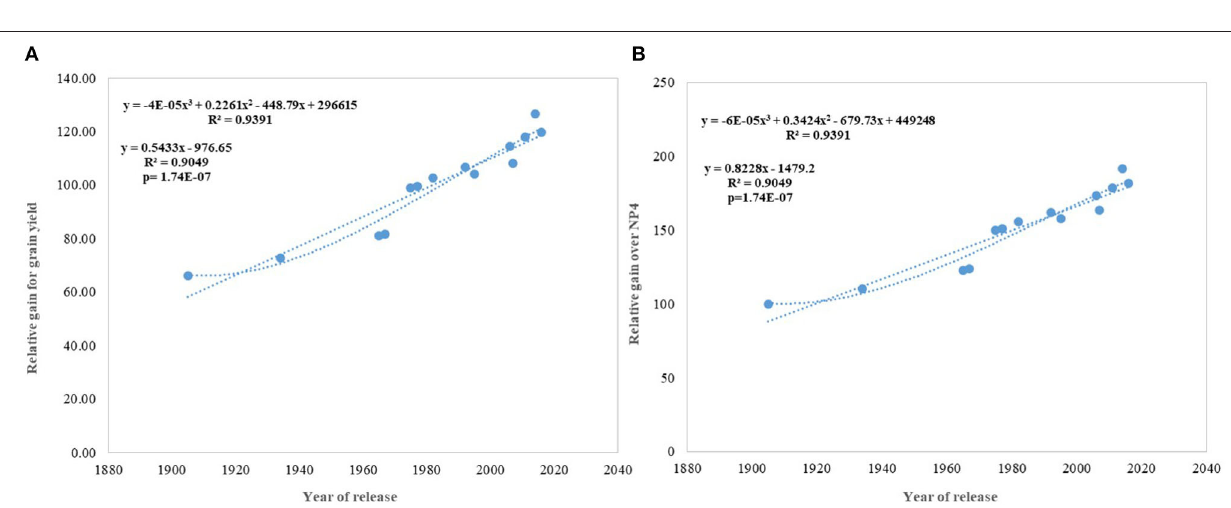
FIGURE 5 | Relative genetic gain over the average of all varieties and NP4 as a base variety. (A) Relative gain for grain yield, (B) Relative gain over